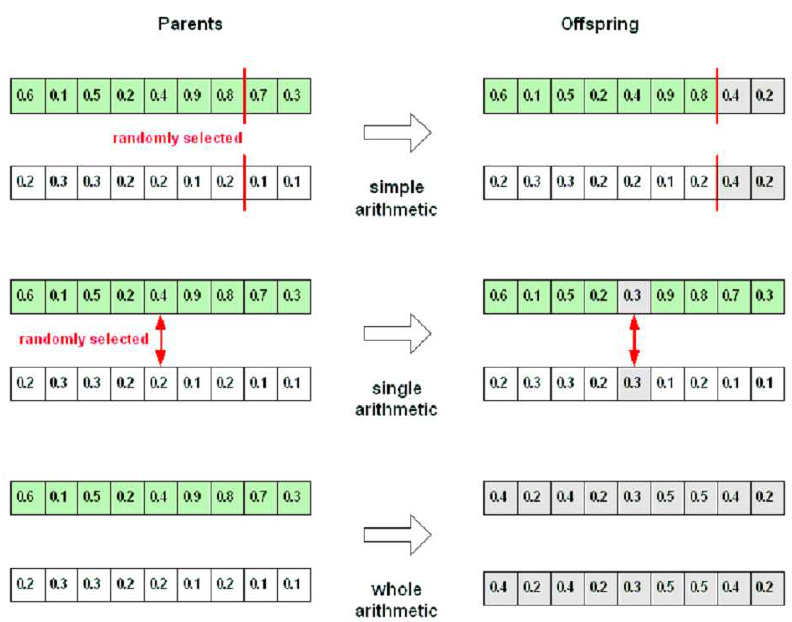
Figure 12. Types of arithmetic recombination; a =